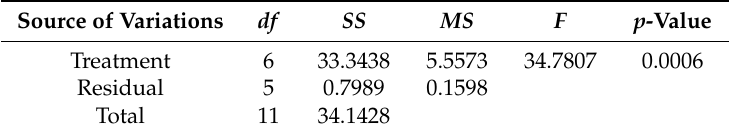
Table 2. Analysis of variance for the correlation fitting expression in Equation